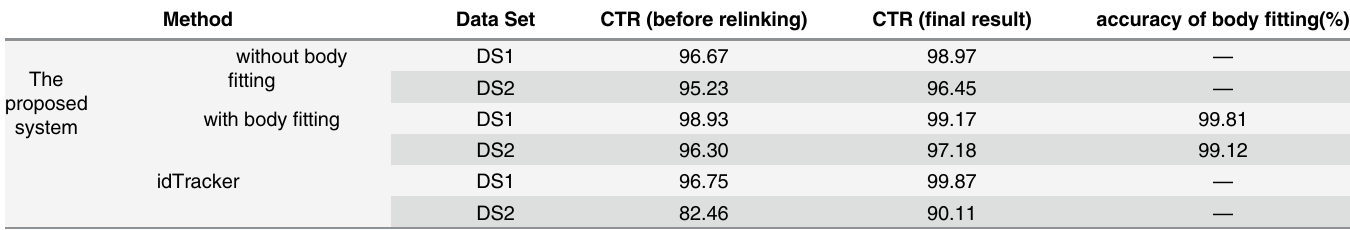
Table 5. CTR of the proposed system and